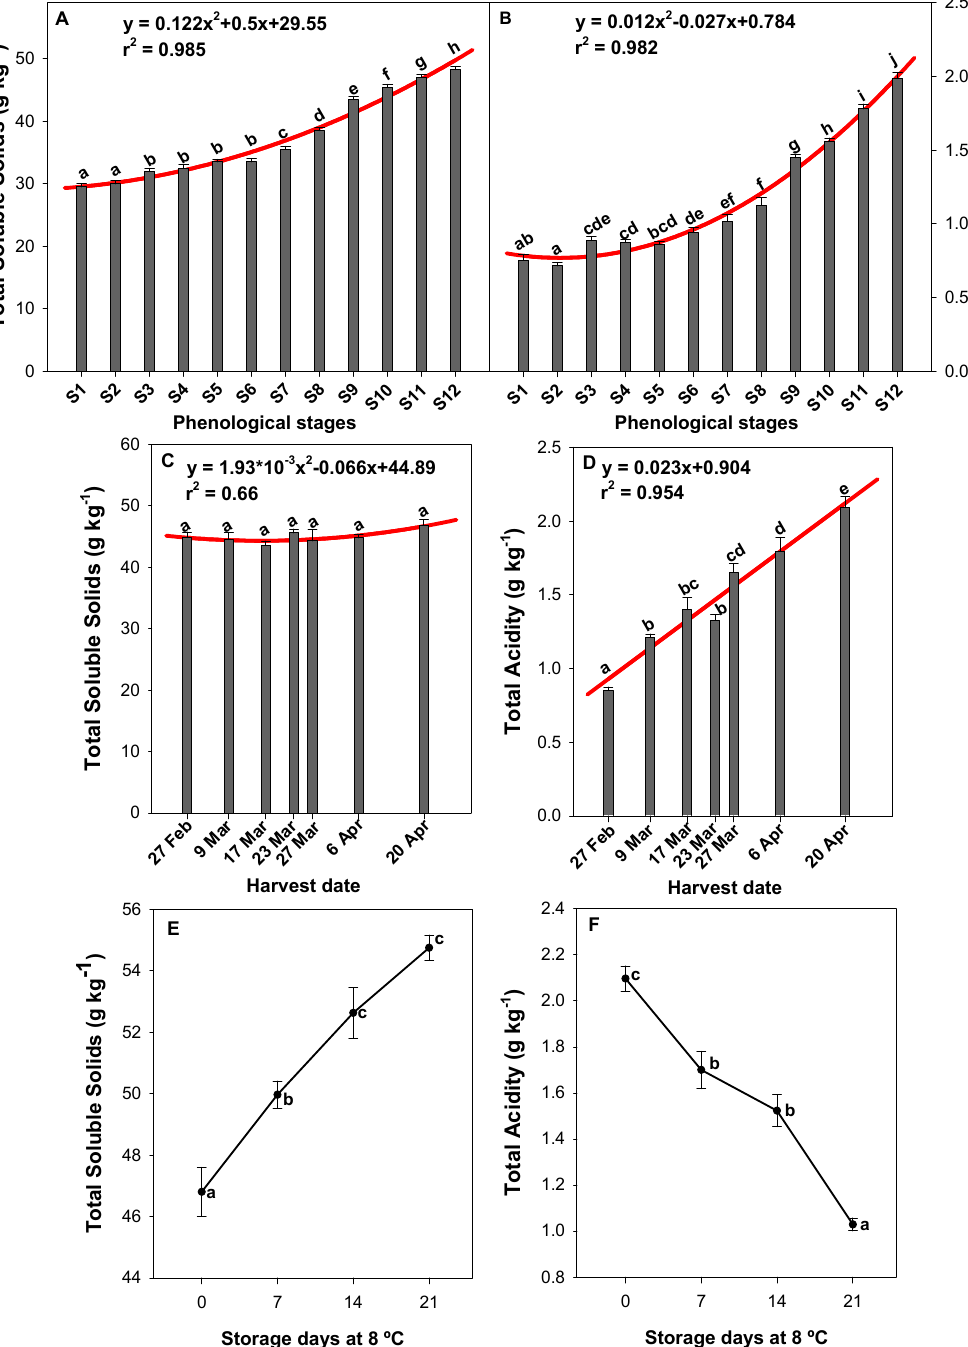
Figure 4. Influence of phenological stages ( A , B ), harvest date ( C , D ), and postharvest storage ( E , F ) on total soluble solids (TSS) ( A , C , E ) and total acidity (TA) ( B , D , F ) (g kg − 1 ) in green pepper fruit. Lowercase letters show significant differences ( p < 0.05) among phenological stages, harvest dates, or storage days at 8 °C. A quadratic model regression and its coefficients are shown in some graphs.